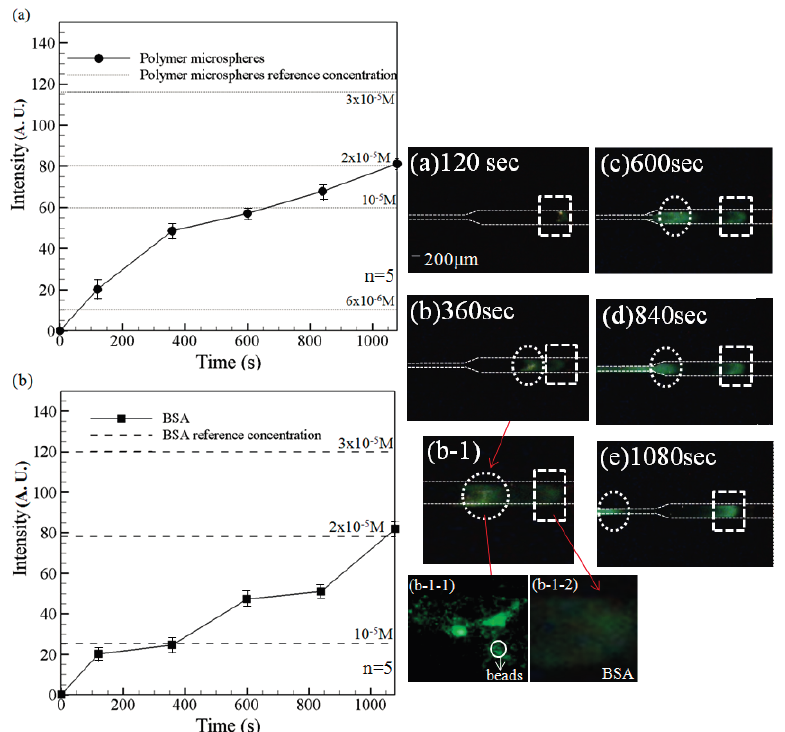
Figure 7. Fluorescence intensity curves of ( a )polymer microspheres and ( b ) BSA (left) and corresponding experimental images at 120 s, 360 s, 600 s, 840 s and 1080 s (right). Note that driving voltage is 100 V. Figure 7b-1-1: beads aggregation in the left peak; Figure 7b-1-2: BSA aggregation in the right peak. Data points represent the mean of five measurements, and the error bars represent one standard deviation from the